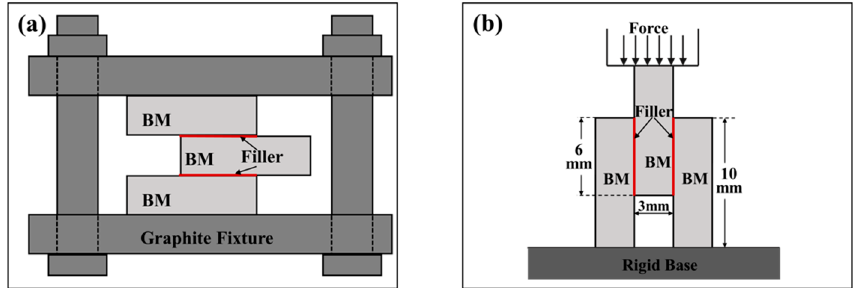
Figure1. Schematicdiagramof( a )assembledsamplebyusinggraphitefixture; ( b Figure 1. Schematic diagram of ( a ) assembled sample by using graphite fixture; ( b ) shear test experiment.